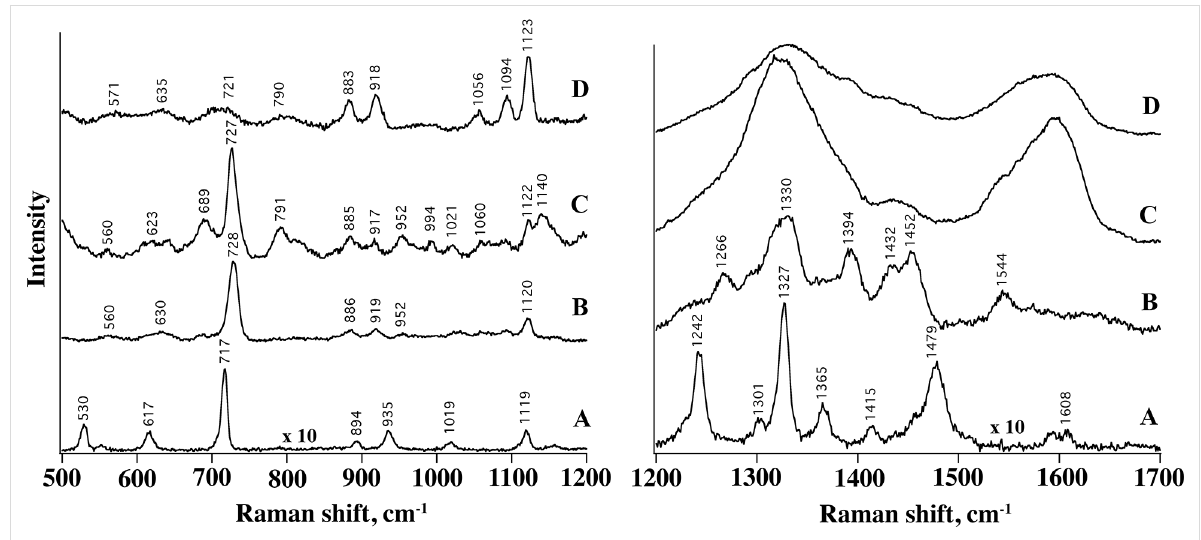
Figure 6: SERS spectra of Adenine (9 × 10 − 7 M) adsorbed on single LB layer of AgNCs (B), on GO/AgNCs obtained with procedure A (C) and with procedure B (D). Raman profile from adenine powder is also shown (A). Left: 500–1200 cm − 1 Raman shift. Right: 1200–1799 cm − 1 Raman shift.